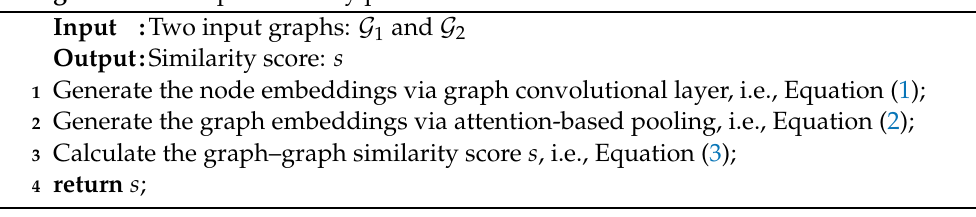
Algorithm 2: Algorithmic description of Conga